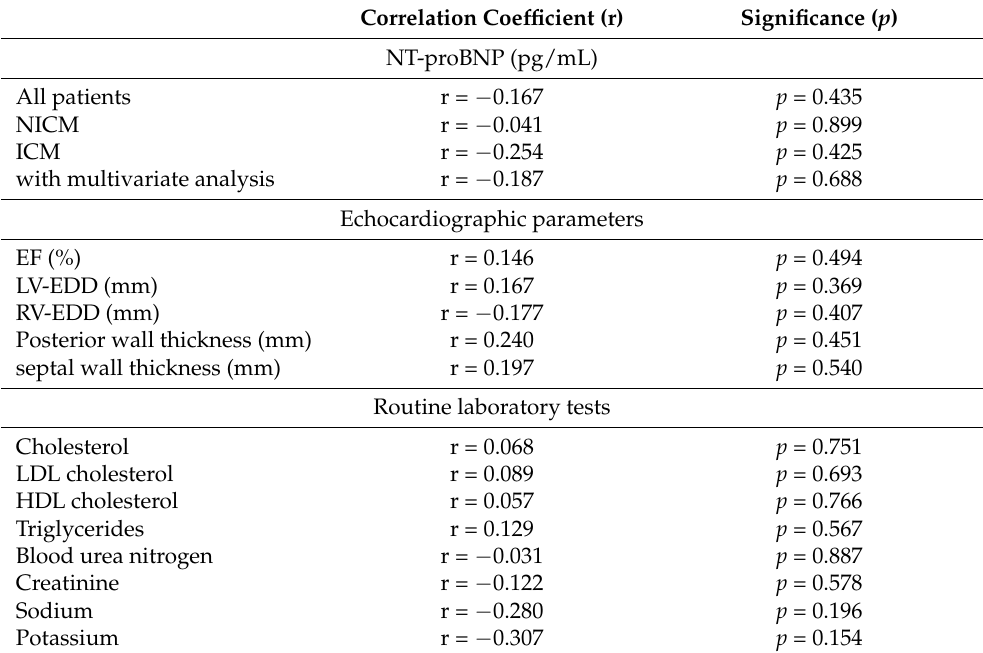
Table 5. Examination of the correlation between the potential influencing factors and tissue PACAP- 38 levels. NICM: non-ischemic cardiomyopathy, ICM: ischemic cardiomyopathy, EF: ejection